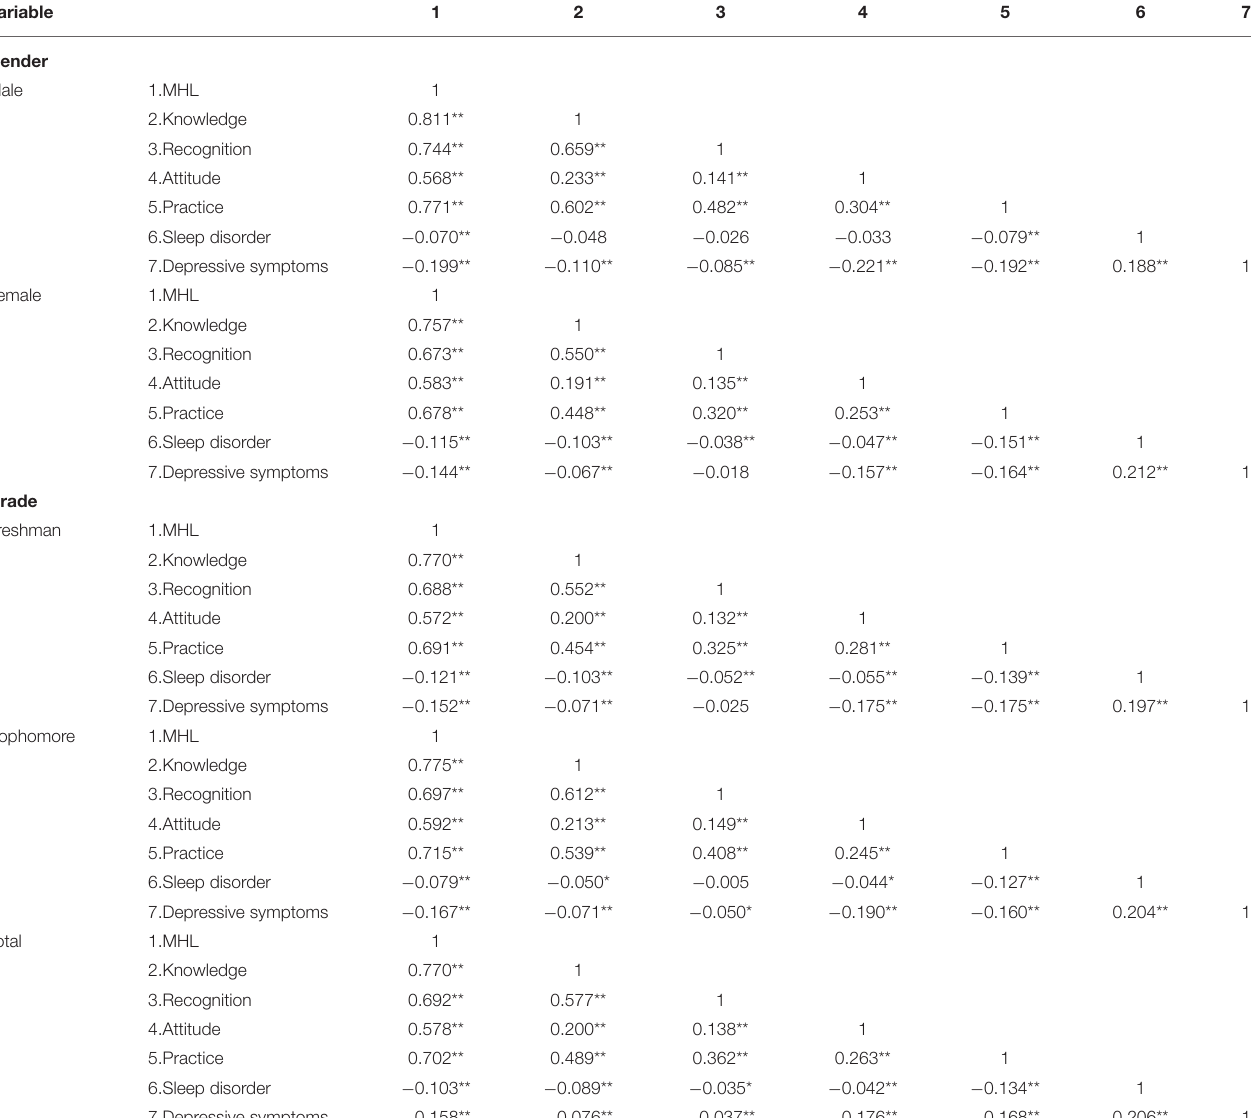
TABLE 3 | Correlations of MHL, sleep disorder and depressive symptoms among Chinese medical students.